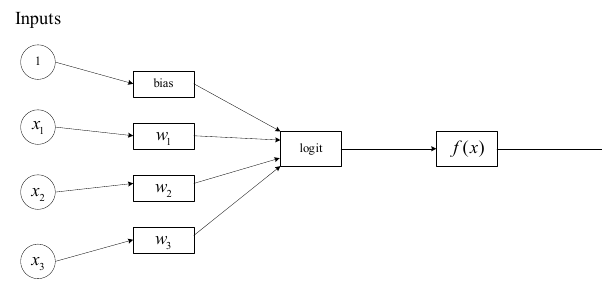
A simple single-layer perceptron calculation is shown in Figure 2. Compared with the perceptron, the MLP introduces the hidden layer of all layers of 𝑅𝑅